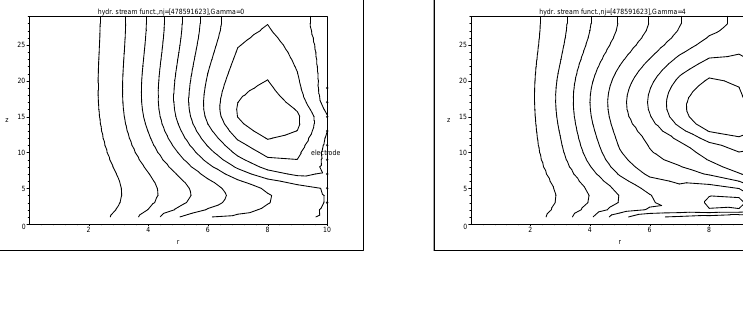
Figure 12. The stream functions for nj = [478591623] , ψ ∈ (0 . 00 , 0 . 22) , Γ = 4 .